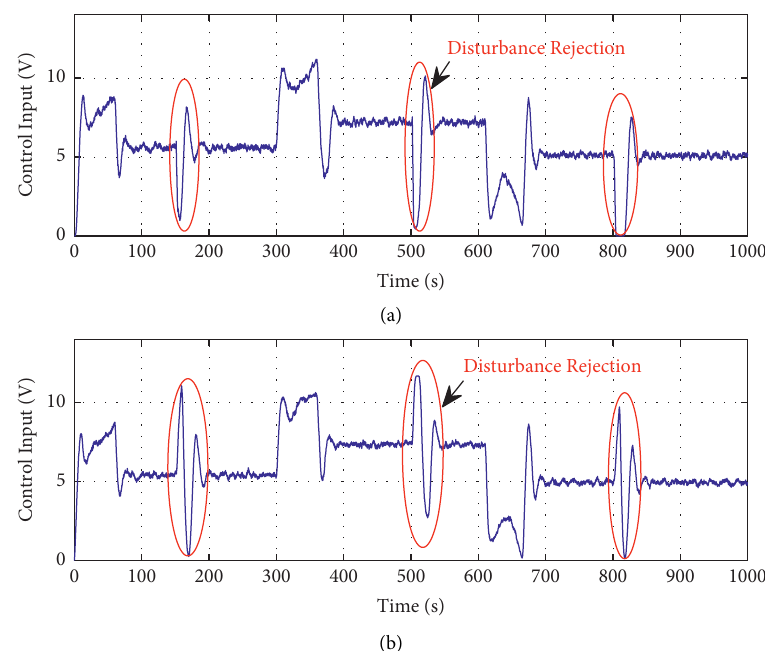
Figure 14: BC voltage with disturbances rejection. (a) With the reaction of reject the external disturbance; (b) with the reaction of rejecting the parameter variation.